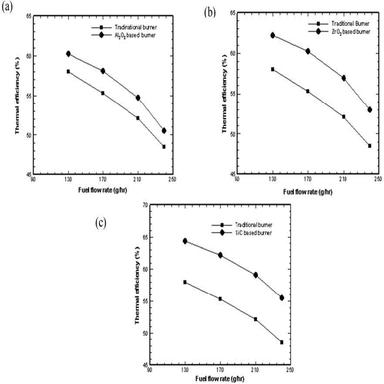
Compare of thermal efficiency of traditional burner w.r.t (a) Al2O3 based burner; (b) ZrO2 based burner ; (c) SiC based burner